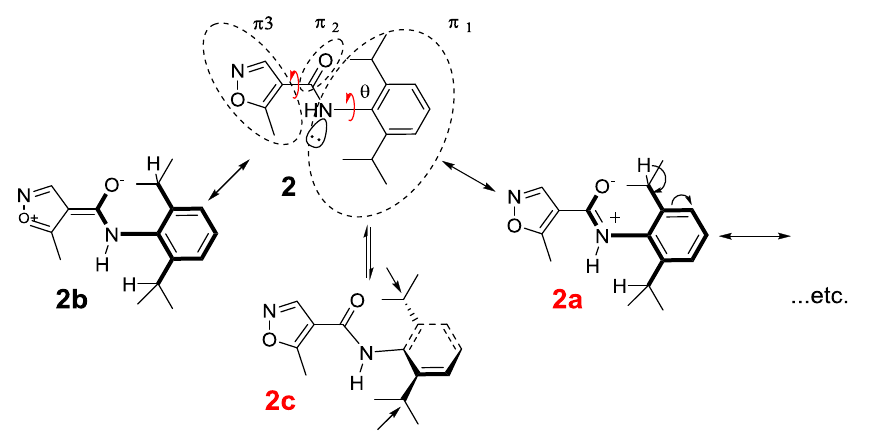
Figure 3. Diverse possible dipolar interaction ( 2a and 2b ) and the most stable conformation with planar carbonyl group ┴ the o -diisopropyl phenyl ring ( 2c ).